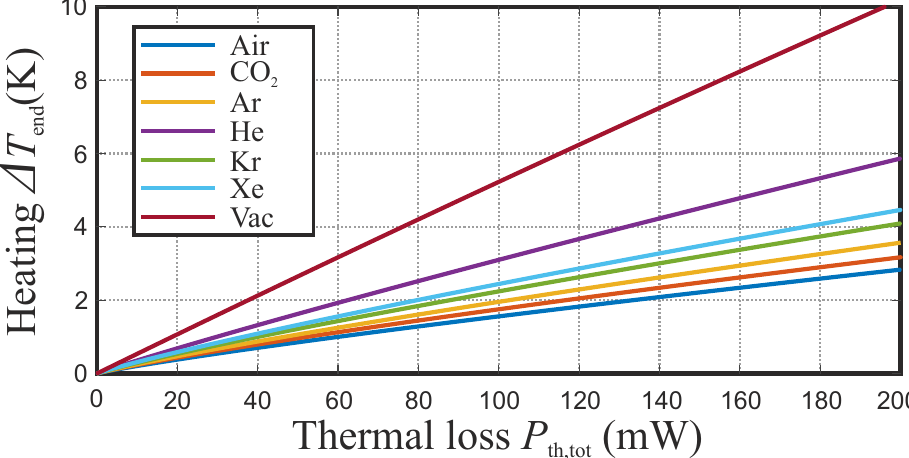
Figure 5. Theoretical temperature change for maximum thermal losses in steady state and different gaseous